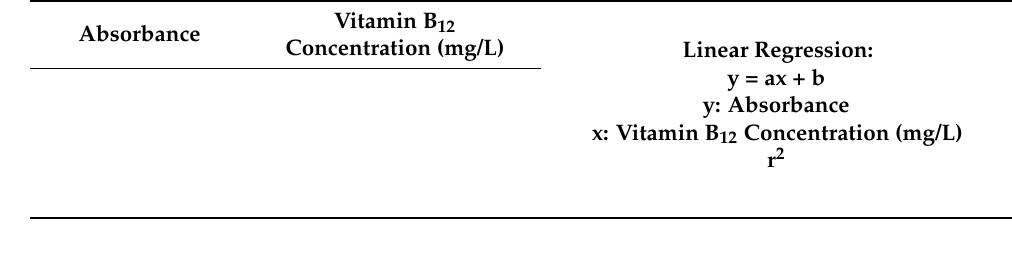
Table A5. Determination of the recovery yield (Ry).